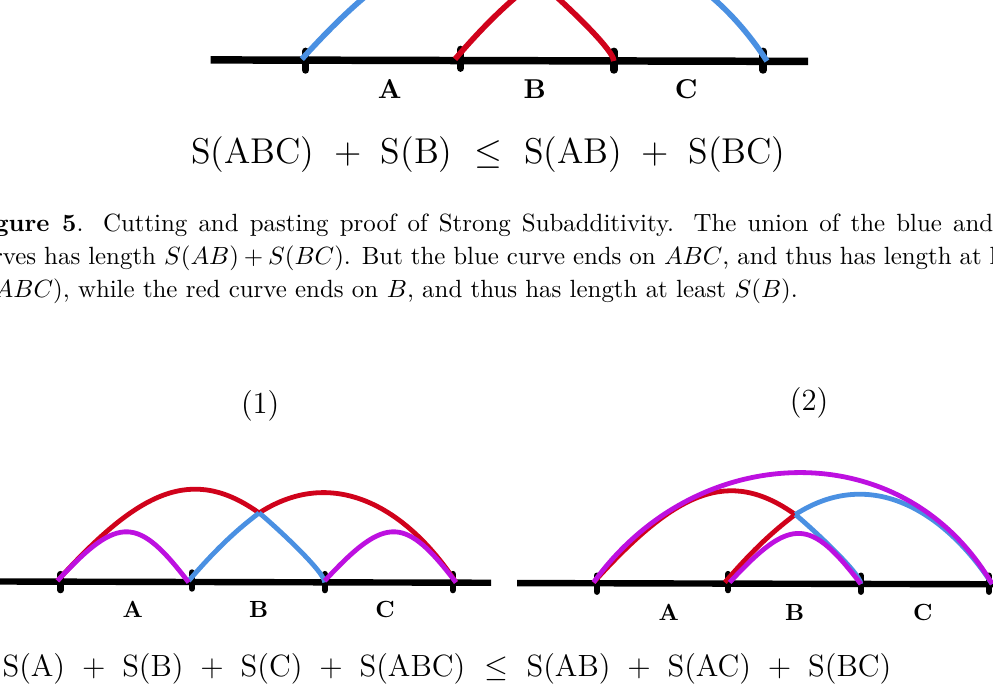
Figure 6 . Cutting and pasting proof of MMI. The proof is divided into two cases according whether S ( AC ) (in purple) is equal to S ( A ) + S ( C ) (case (1)) or S ( ABC ) + S ( B ) (case (2)); the two cases correspond to the disconnected and connected cases in figure 7, respectively. In both cases, the union of the blue and red curves has length S ( AB ) + S ( BC ) . In case (1), the length of the red curve is lower-bounded by S ( ABC ) and the length of the blue curve is lower-bounded by S ( B ) . In case (2), the length of the red curve is lower-bounded by S ( A ) and the length of the blue curve is lower-bounded by S ( C ) . (The holographic proof of MMI in [5] combines these cases, but we have separated them here for